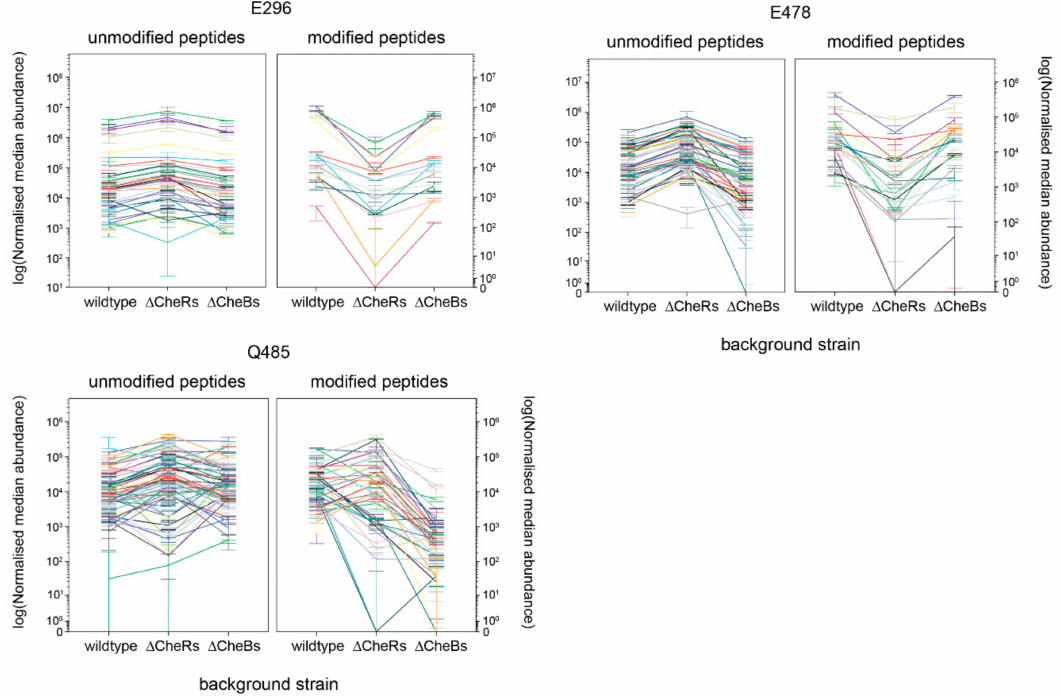
Figure 4. Relative abundance of each R. sphaeroides TlpT peptide (modified or unmodified) in the three backgrounds, WS8N (wild-type), JPA3265 (all CheB homologues deleted) and JPA2366 (all CheR homologues deleted), for glutamate and glutamine sites with modifications in over 5% of identified peptides that showed a regulatory pattern consistent with adaptation. Each measurement was done in triplicate, with the median shown and error bars showing min and max. Each colour within a panel represents one peptide containing that